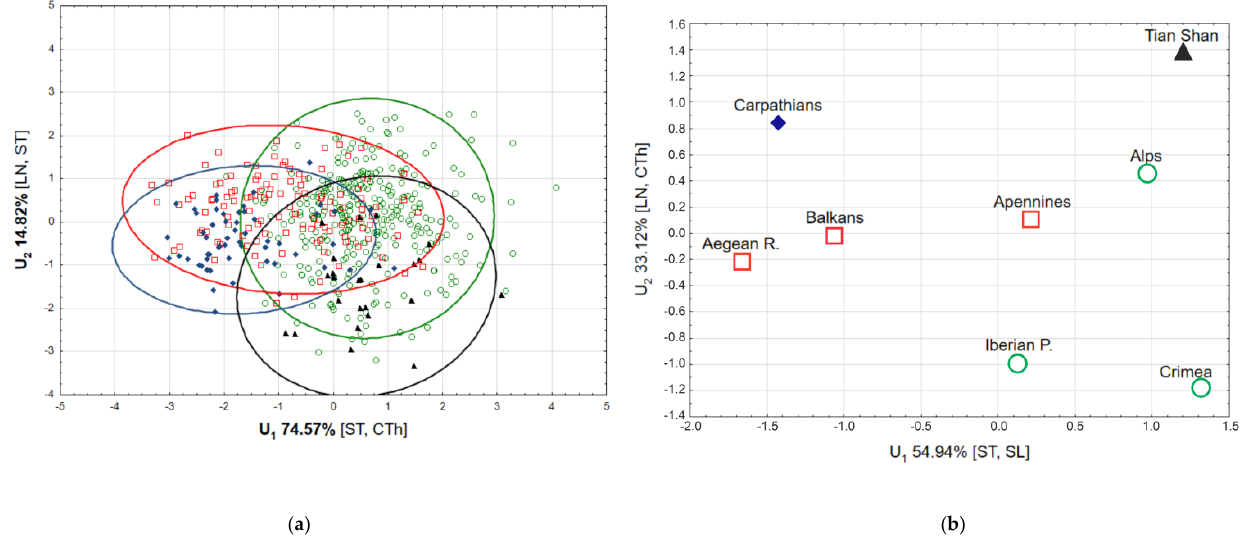
Figure 3. Scatterplots showing results of discrimination analysis of J. sabina . ( a ) All individuals means. The variety sabina − green circles. The variety balkanensis − red squares. Tian Shan mountains − black triangles. The Carpathians − blue diamonds. Confidence ellipses with p < 0.05 colours of lines as above. ( b ) Means of regions (Table 1). In square brackets − codes of characters the most strongly connected with the discriminant variable.